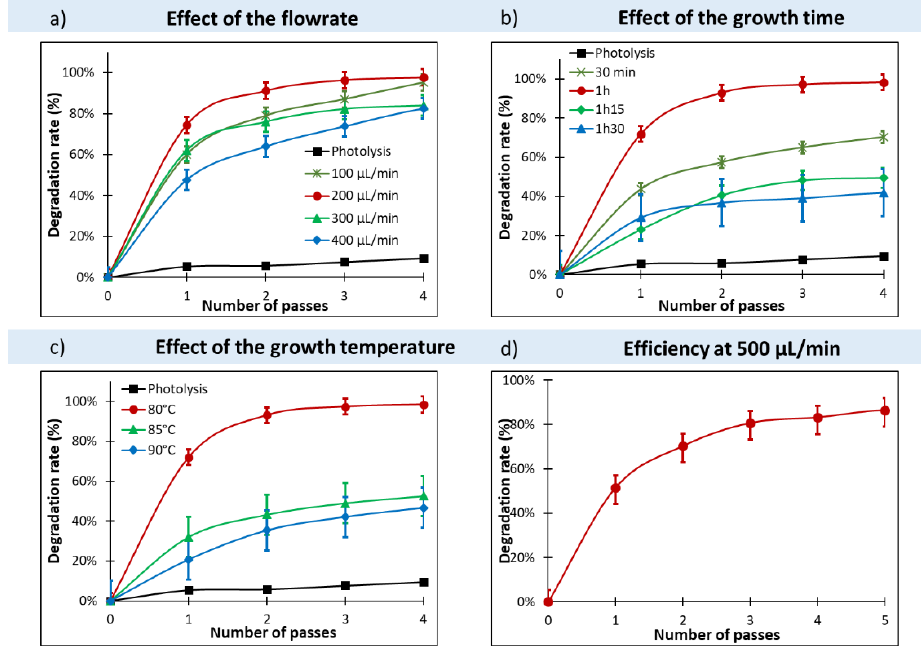
Figure 7. Effect of the different growth conditions ( a ) flowrate, ( b ) growth time and ( c ) growth temperature and effect of the augmentation of the photocatalysis flowrate ( d ) on the photocatalytic efficiency of the samples for AR14 degradation under UV light (~365 nm, I received by the sample = 35 mW/cm², reproduced from [30] with permission of the Royal Society of Chemistry).